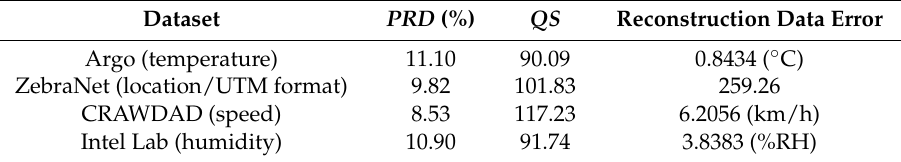
Table 2. Model performance on other datasets.